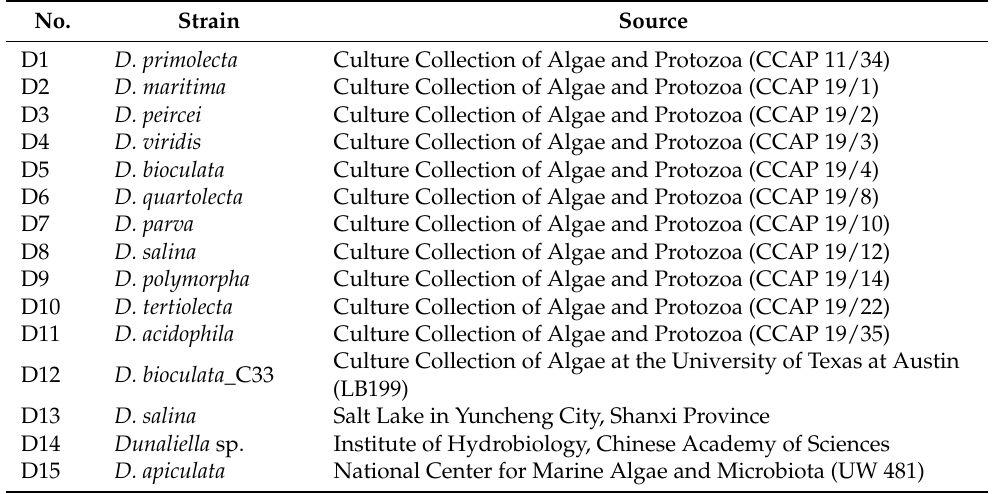
Table 1. Algae information for the 15 Dunaliella species.